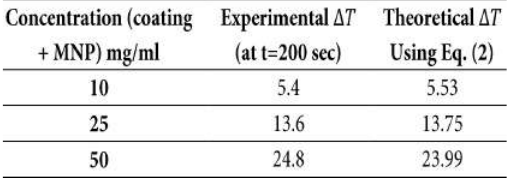
Table 1. SAR graphical measurement based on Equation 1